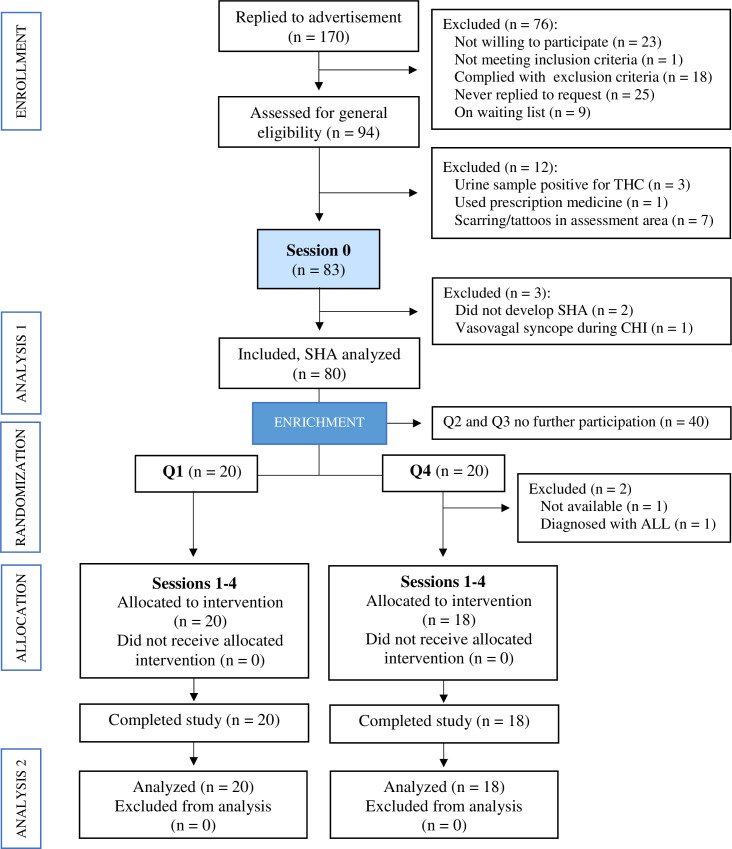
CONSORT flow diagram.A total of 170 individuals replied to the advertisement. Ninety-four subjects were assessed for general eligibility on an enrichment selection session (Session 0). Twelve subjects were excluded before the assessments, three tested positive for tetrahydrocannabinol (THC) in their urine, one used prescription drugs and seven had scars or tattoos in the assessment areas. Eighty-three subjects received a cutaneous heat injury (CHI) on Session 0. Subsequently, three subjects were excluded, two subjects did not develop secondary hyperalgesia areas (SHAs), and one subject had a vasovagal syncope following the CHI. Eighty subjects’ SHAs were analyzed and ranked according to magnitude, assessed by planimetric measurements. Through an enrichment process, 40 subjects with SHAs in the two middle quartiles (Q2/Q3) were discontinued, while the 20 subjects belonging to the lower quartile (Q1) and the 20 subjects belonging to the upper quartile (Q4) were randomized and continued to the experimental sessions. Two subjects from Q4 were, however, excluded before the allocation procedure in Session 1 for reasons unrelated to the trial, one subject was unavailable, and another was diagnosed with acute lymphocytic leukemia (ALL). All other subjects completed per-protocol the trial sessions, and the final analysis, thus, included 38 subjects.